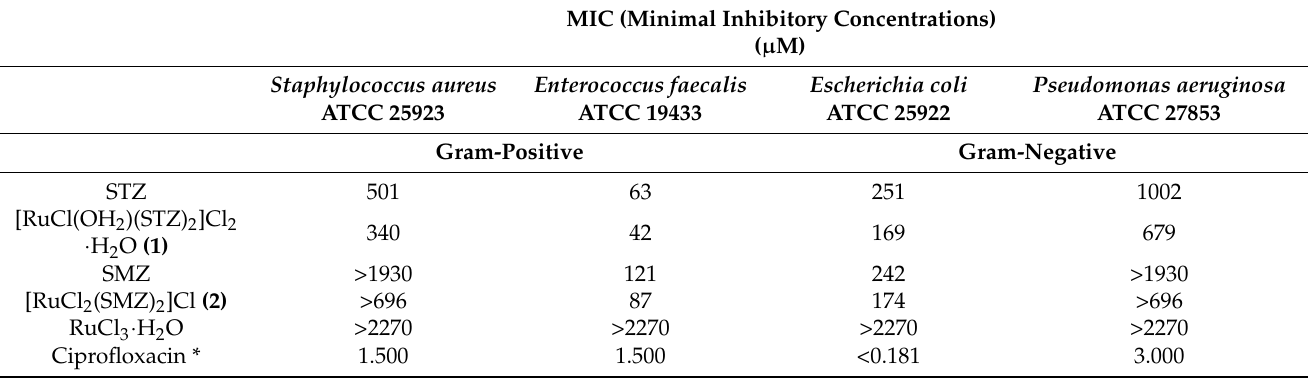
Comparison of minimal inhibitory concentrations (MIC) of STZ, [RuCl(OH 2 )(STZ) 2 ]Cl 2 · H 2 O (1) , SMZ, [RuCl 2 (SMZ) 2 ]Cl (2) and RuCl 3 · H 2 O and